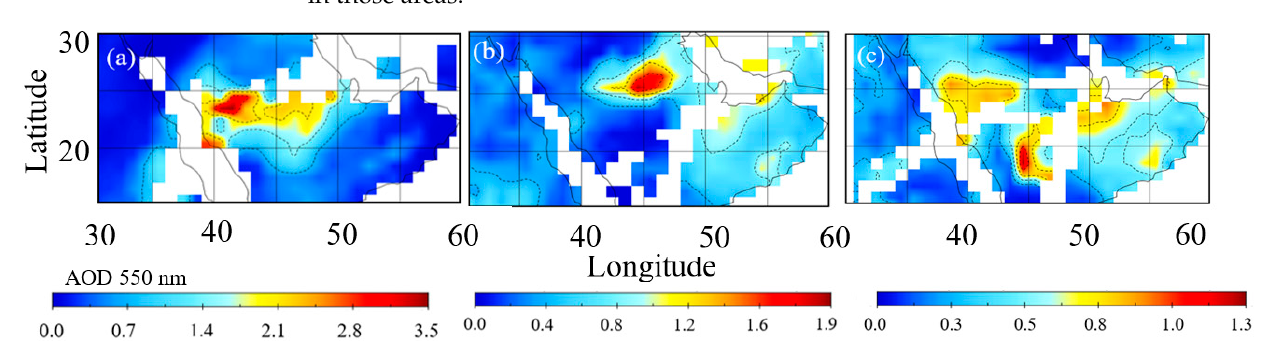
Figure 3. AOD at 550 nm during some major dust storms blown over Saudi Arabia on ( a ) 20 March